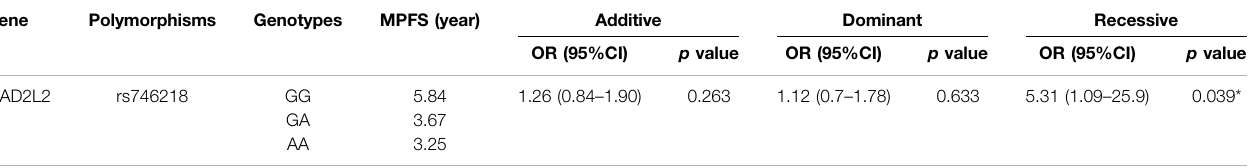
TABLE 3 | Association of the MAD2L2 rs746218 polymorphisms and PFS in lung cancer patients. Gene